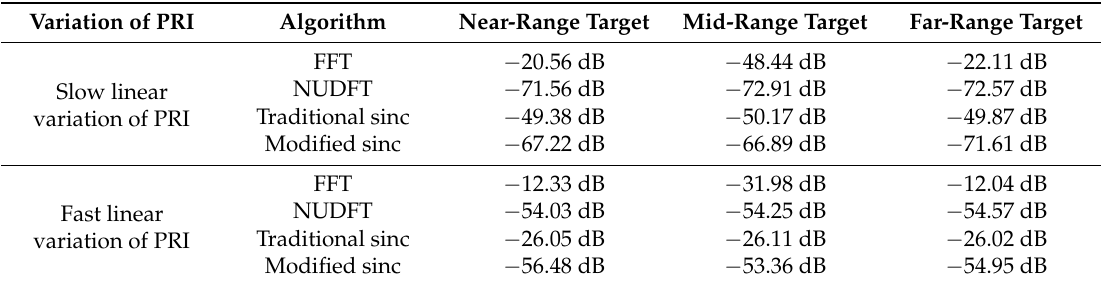
Table 3. False targets level of the point targets of Figures 4 and